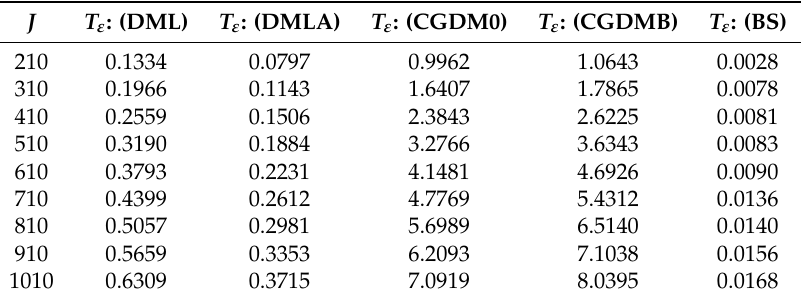
Table 14. Results for Case E with m = 25, ε = 10 − 2 .